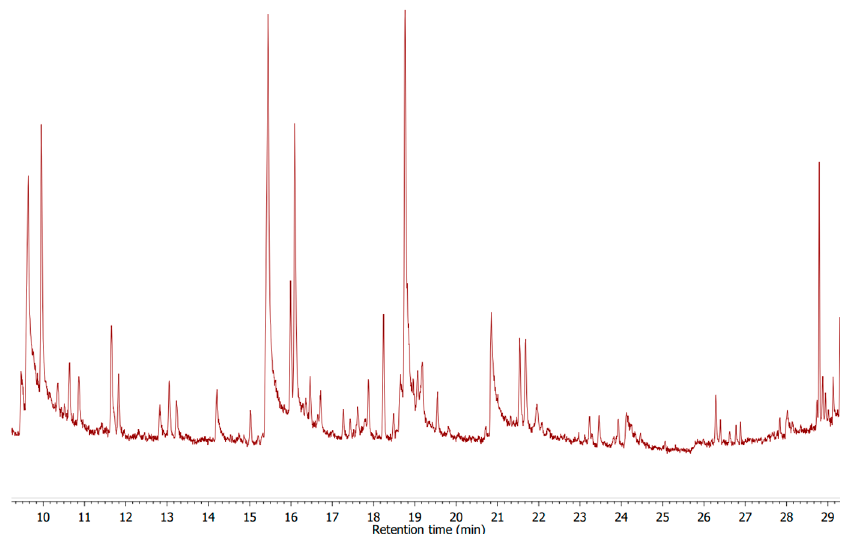
Figure 4. Typical chromatogram of an analysis of the volatile components of cheese by